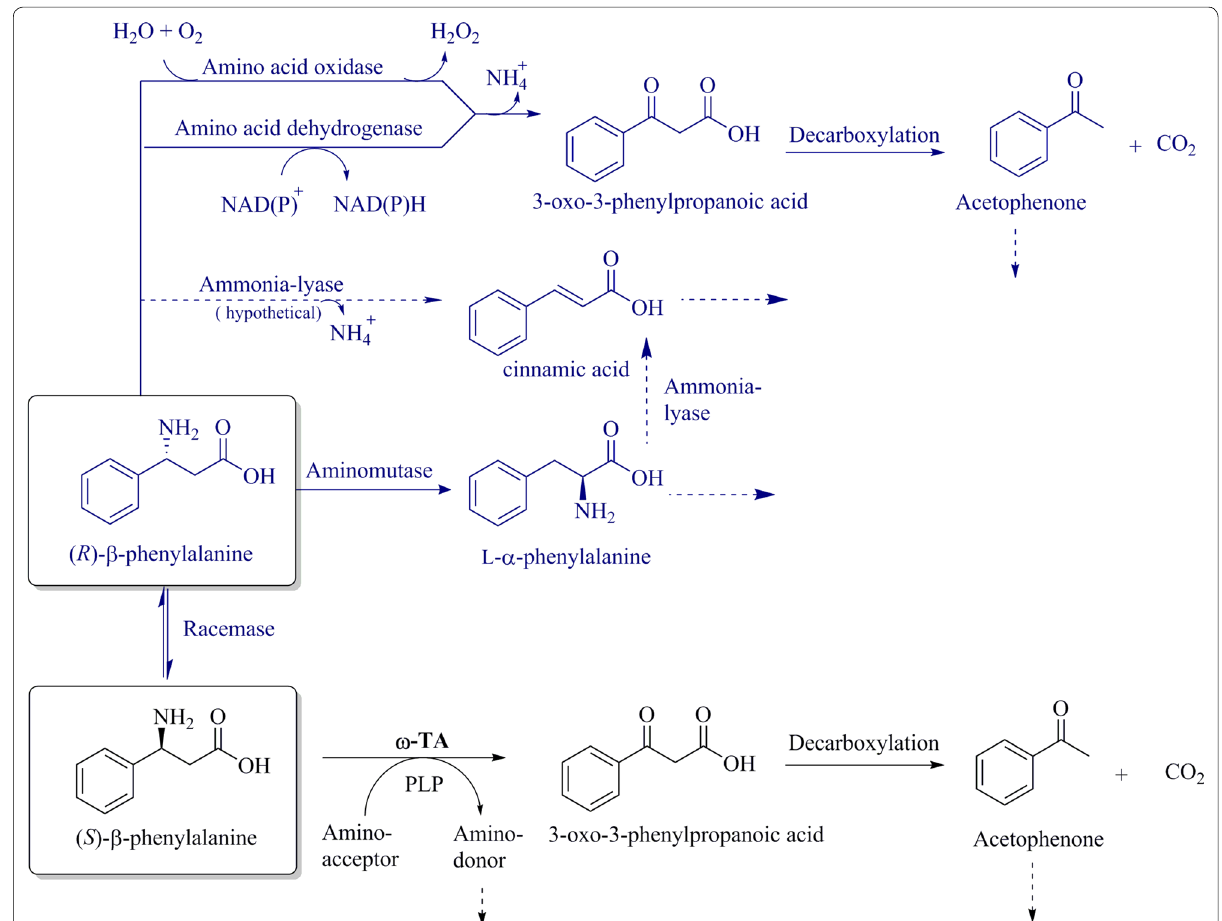
Fig. 4 Putative degradation mechanisms of ( R )‑β‑PA. In blue: putative degradation mechanisms of ( R )‑β‑PA. Since AP no longer emerges when ( R )‑β‑PA is consumed but rather decreases during fermentation (see again Additional file 1: Figure S1a), the reactions via aminomutase appear to be more likely. Bacterial ammonia lyases (dashed arrow) with activity towards β‑PA have not yet been reported. In black: identified degradation pathways of ( S )‑β‑PA. The degradation of ( S )‑β‑PA occurs via transamination and leads to the formation of AP reciprocal to ( S )‑β‑PA decline (as shown in Additional file 1: Figure